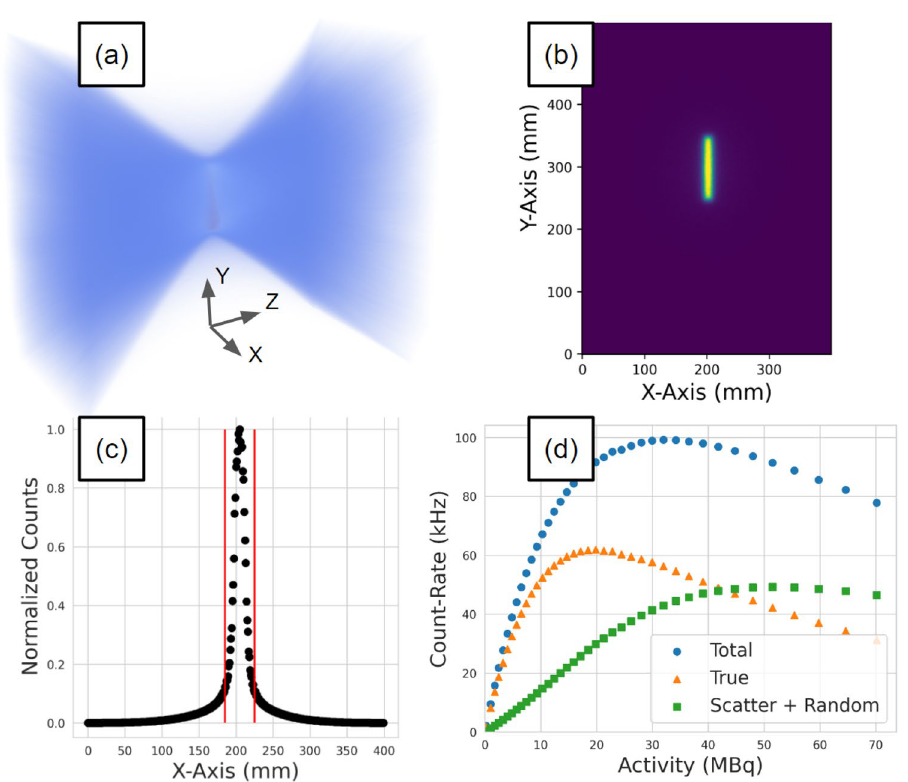
Figure 2. A demonstration of the protocol for extracting count rates from a sample of LoRs: ( a ) a sample of LoRs collected during the experiment is converted into voxels, ( b ) the slice containing the maximum number of LoRs is extracted, ( c ) the slice is collapsed into a line profile and the counts in the central 40 mm strip are summed and background counts subtracted to yield a total, true, and scattered + random count-rate ( d ). Steps a-c are repeated for multiple samples to generate the count-rate response as a function of